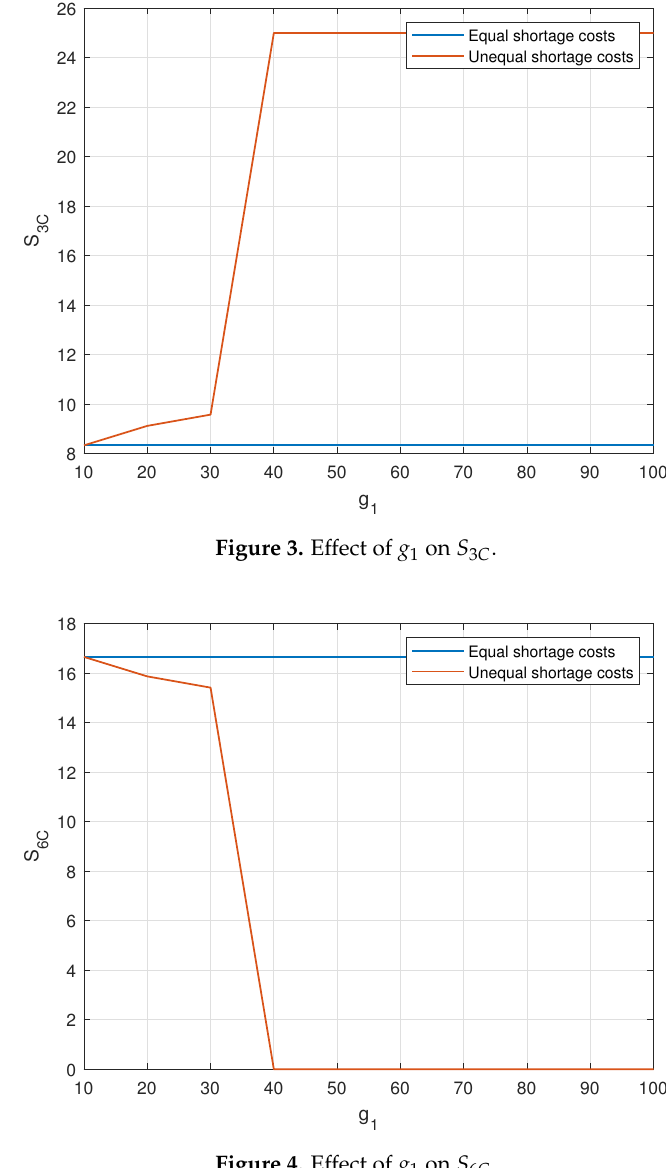
Figure 4. Effect of g 1 on S 6 C